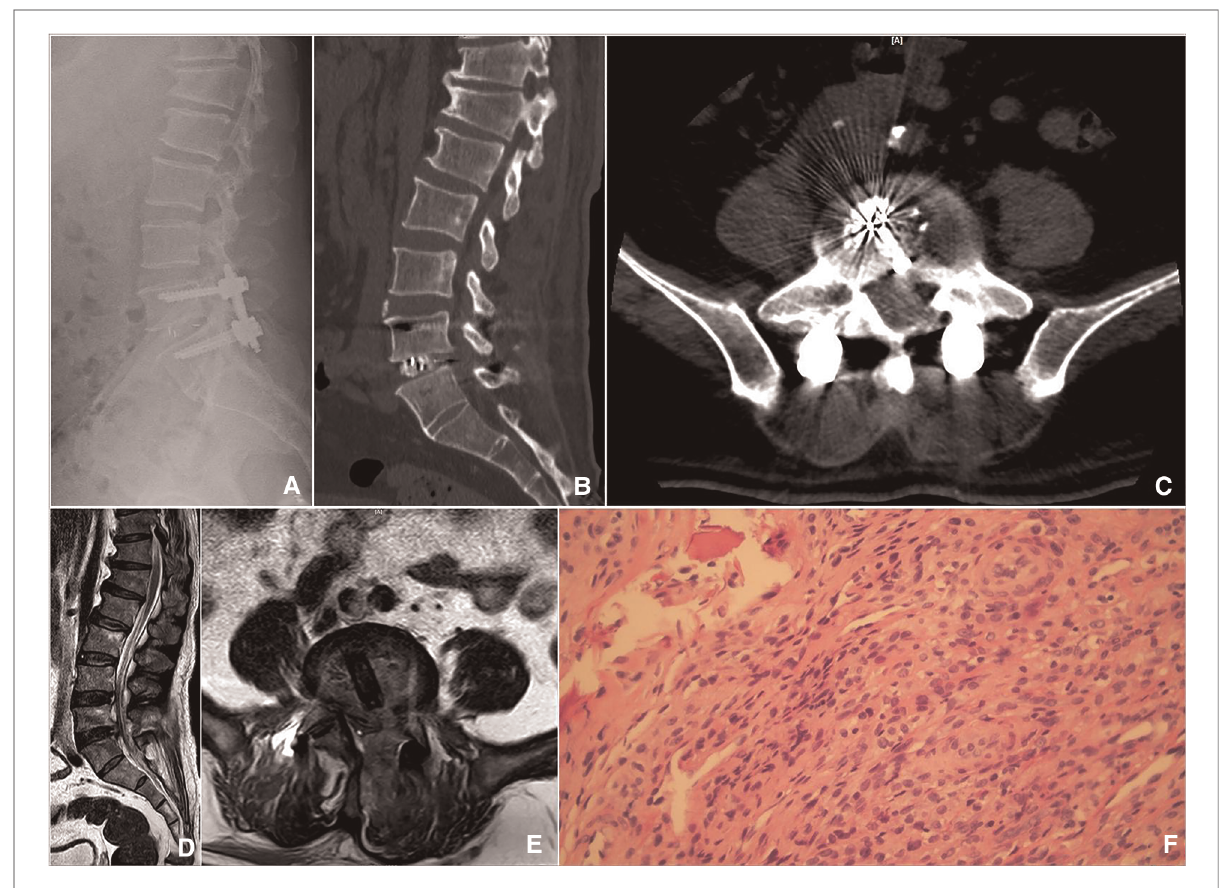
FIGURE 3 Postoperative imaging and pathological fi ndings. ( A ) The lateral radiograph showed intervertebral bone grafting and instrumentation. ( B ) Sagittal CT showed that suf fi cient bone was planted. ( C ) Axial CT showed a good position of the Cage. ( D,E ) Sagittal and axial MRI showed suf fi cient decompression and abscess debridement. ( F ) Hematoxylin and eosin staining showed lymphocyte and monocyte in fi ltration in the samples biopsied.